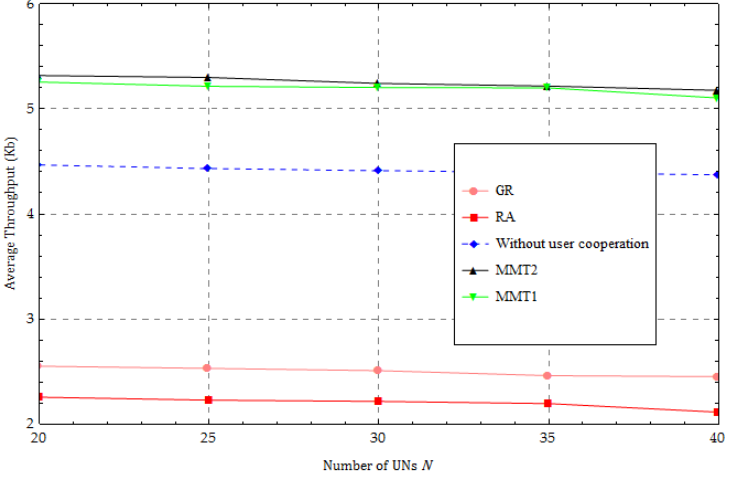
Figure 10. Change in the number of user nodes.